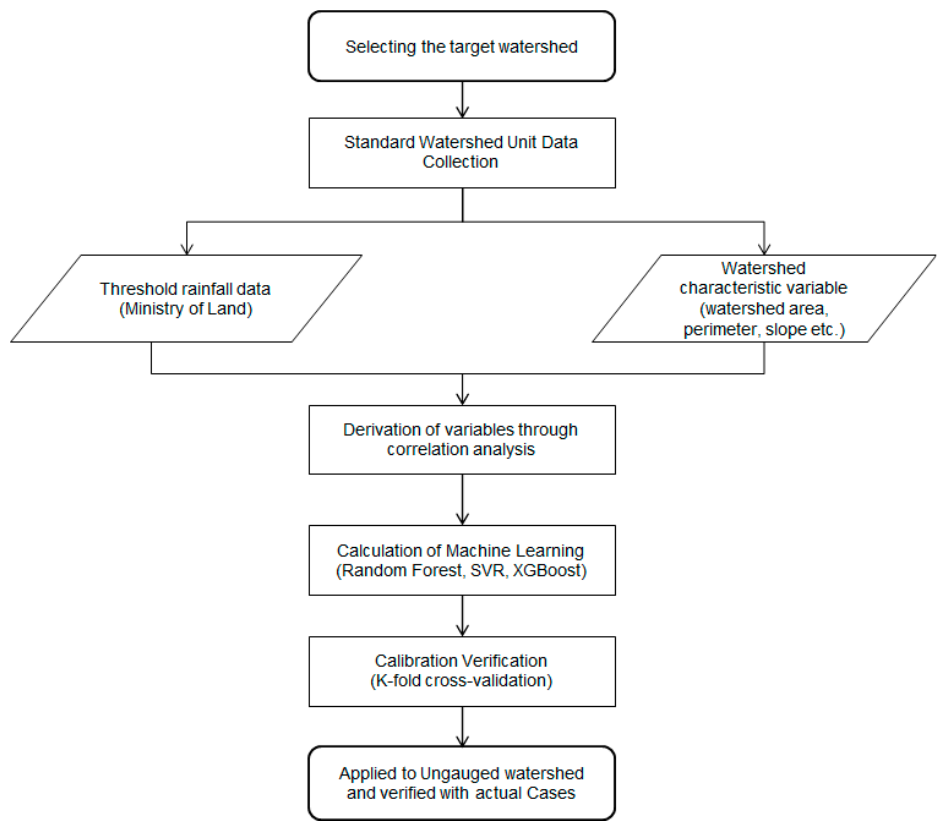
Figure 1. Flowchart of